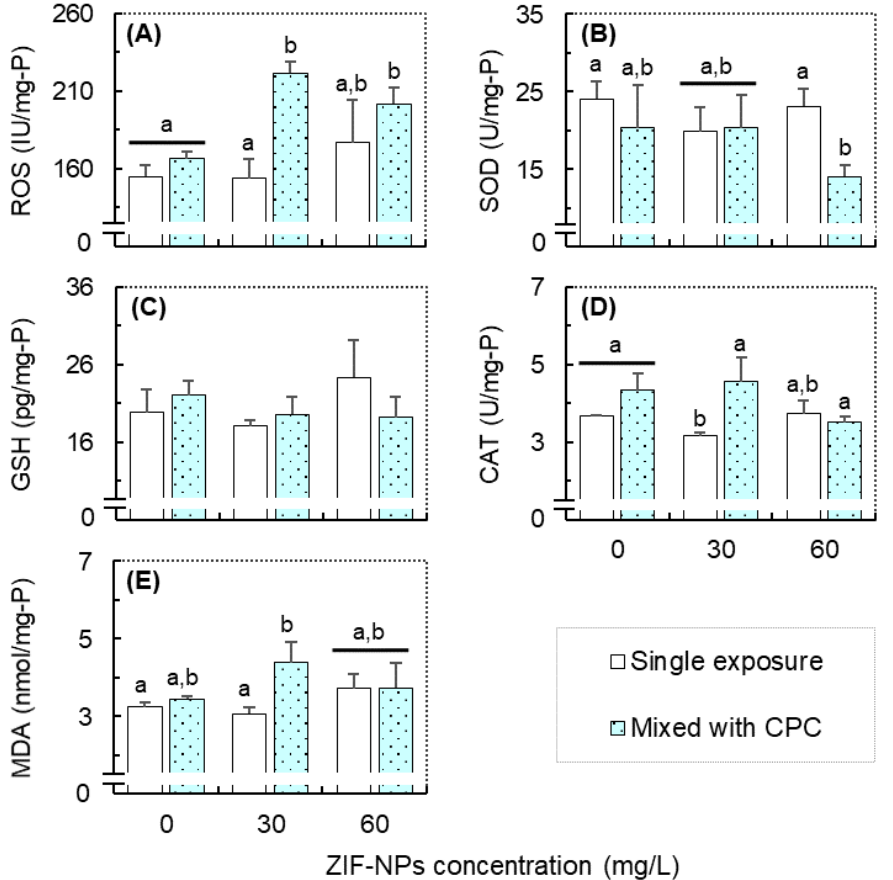
Figure 4. The levels of ROS ( A ), T-SOD ( B ), GSH ( C ), CAT ( D ), and MDA ( E ) in larval zebrafish in combined exposure groups of cetylpyridinium chloride (CPC; 0 and 20 µ g/L) and ZIF-8 nanoparticle (ZIF-NPs; 0, 30, and 60 mg/L). Data are mean ± SE ( n = 3), and values that do not share a common letter are significantly different at p < 0.05.